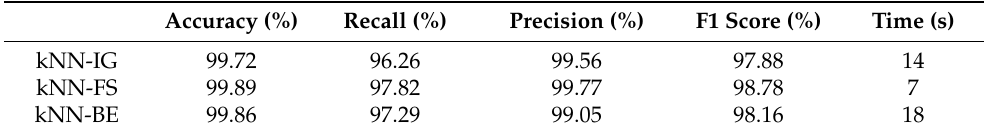
Figure 13. Level of accuracy, recall, precision and F1 score.